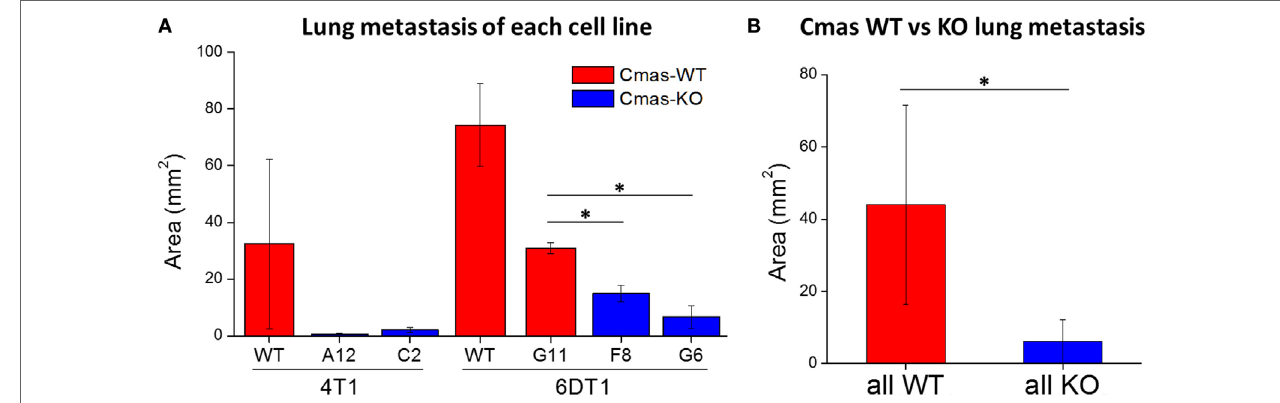
FigUre 8 | Orthotopic injection of Cmas -KO cells result in less lung metastasis compared to Cmas -wild-type (WT). (a) Average metastatic tissue area for each injected cell line. Values are the average of three (4T1 WT, 6DT1 G6) or two (all other cell lines) biological replicates, and error bars represent SD. (B) Average metastatic tissue area across all Cmas WT injections versus all Cmas -KO injections. Values are the average of seven total samples in the WT group and nine total samples in the KO group. Error bars represent SD. Statistically significant differences ( p -value < 0.05) are marked with asterisks